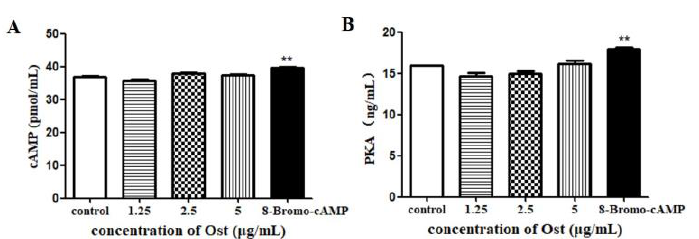
Figure 8. The level of cAMP( A ) and PKA( B ) in granulosa cells lysates were determined by ELISA. 8- Bromo-cAMP (Topscience, Shanghai, China) was used as a positive control. Data were expressed as Mean ± SEM. ** p < 0.01.